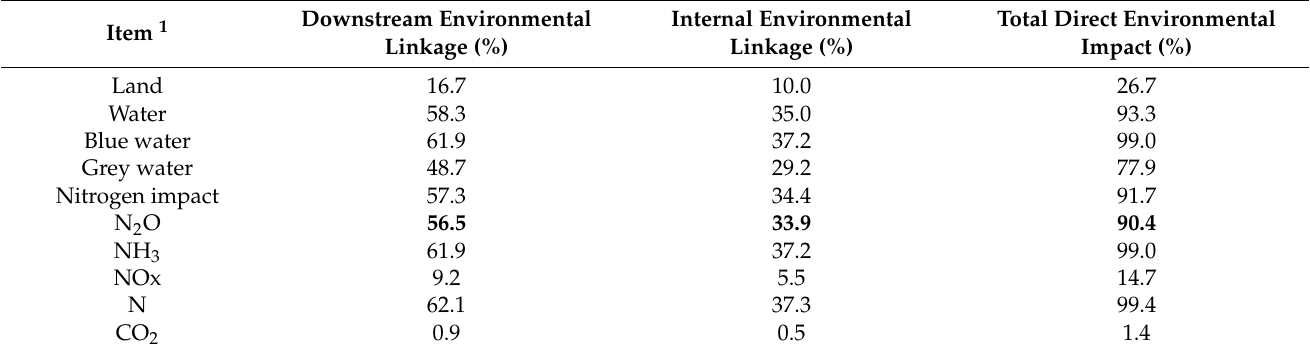
Table 2. The contribution of Pakistan’s agriculture sector’s direct environmental impacts and sectoral linkages to total environmental impact of Pakistan.